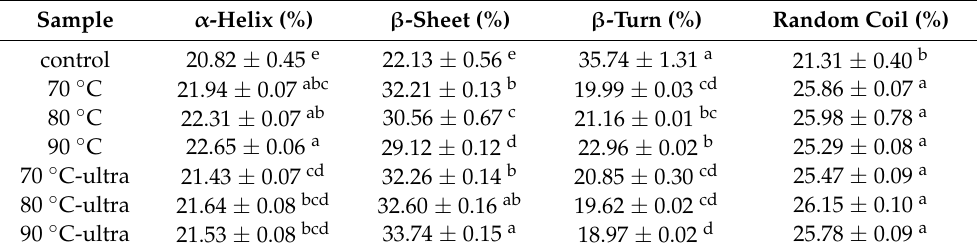
Table 1. Secondary structures of different coconut globulin samples (ultra: 53 kHz, 40 w / l , 20 min; 70, 80 and 90 ◦ C represent preheating for 20 min). Different letters indicate significant differences at p < 0.05. Sample α -Helix (%) β -Sheet